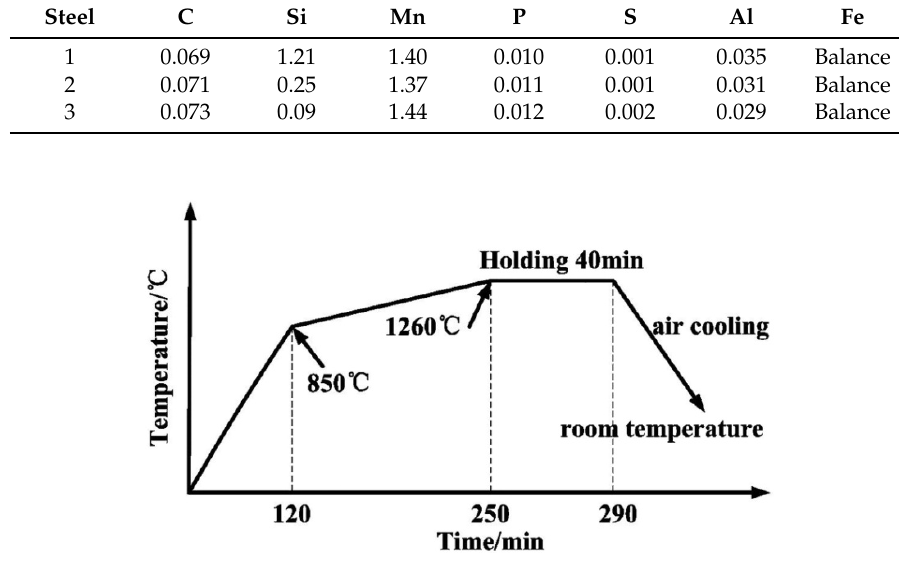
Figure 1. The heating procedure.